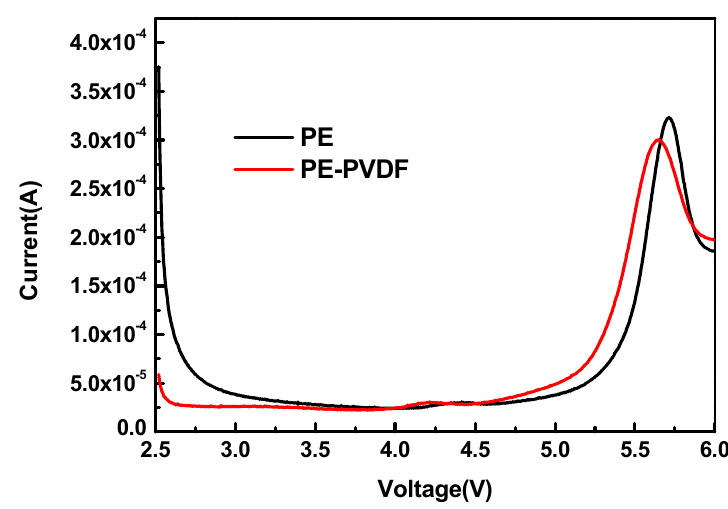
Figure 7. Linear sweep voltammetry of bare PE and PE-PVDF separators.